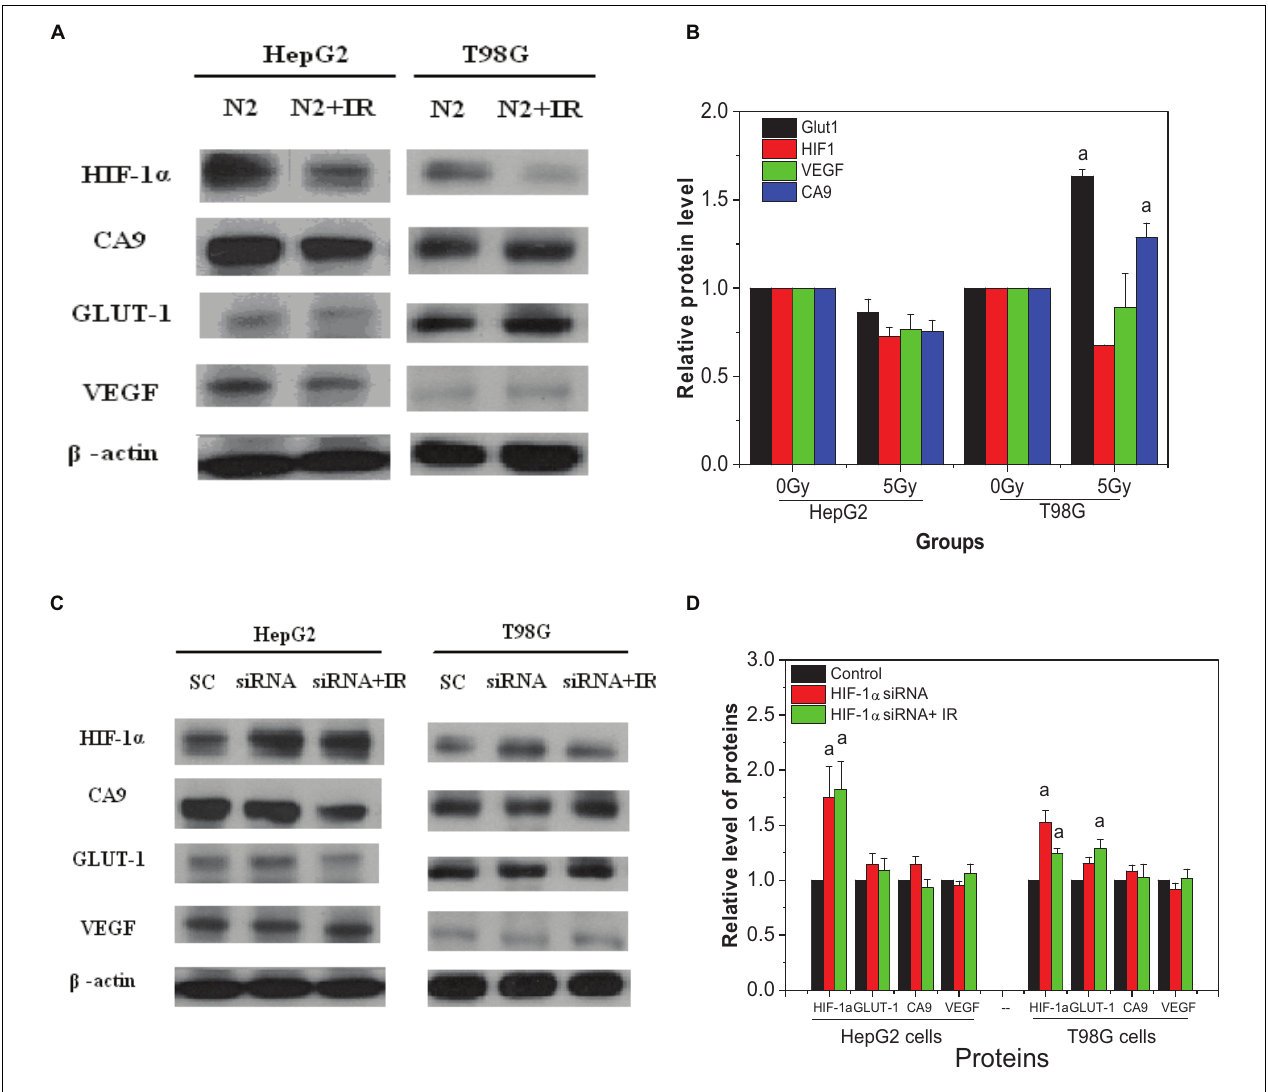
FIGURE 8 | Expression of HIF-1 α and related downstream proteins on the bystander cells induced by the conditioned medium under hypoxic conditions. (A,B) Hypoxic bystander cells were treated with the conditioned medium from hypoxic-irradiated HepG2 and T98G cells. (C,D) Hypoxic bystander cells were exposed to the conditioned medium from irradiated cells with or without inhibitor pretreatment. Each HIF-1 α signal and its downstream protein were compared with the corresponding β -actin signal and then normalized to that protein under hypoxia conditions. a, p < 0.05 compared with the hypoxic control without